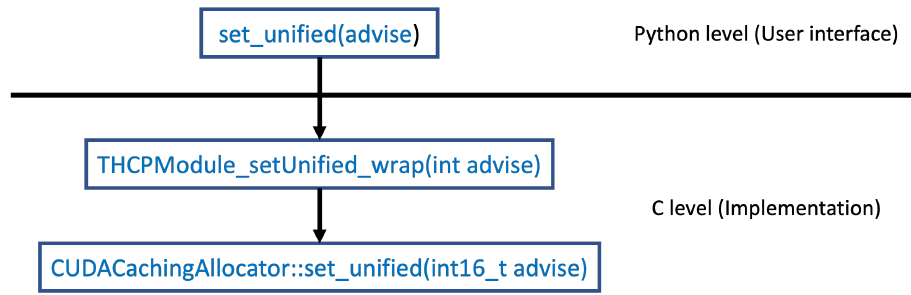
Figure 3. Sequence of function calls to pass memory advise of intermediate results. (The functions we added are colored in blue.)